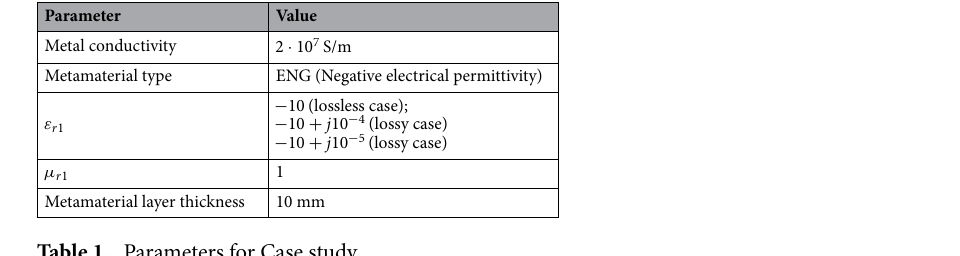
Table 1. Parameters for Case